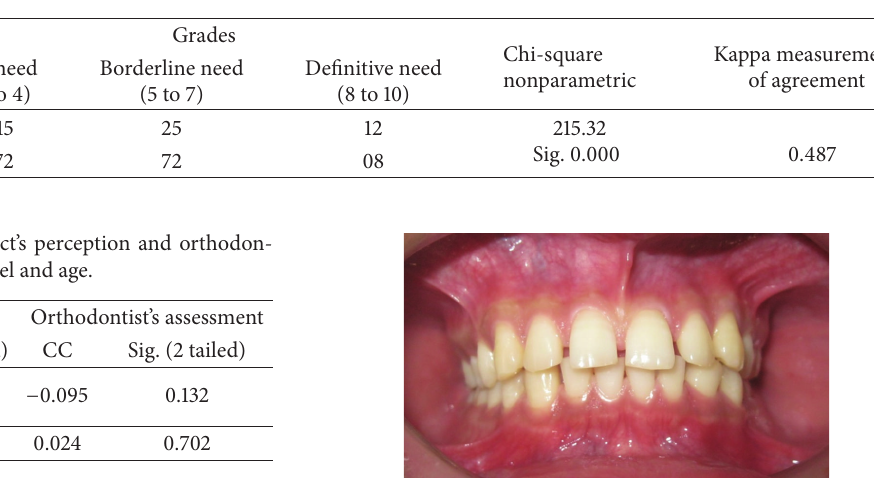
Table 4: Effect of variables (rural/urban, sex, and demand) on